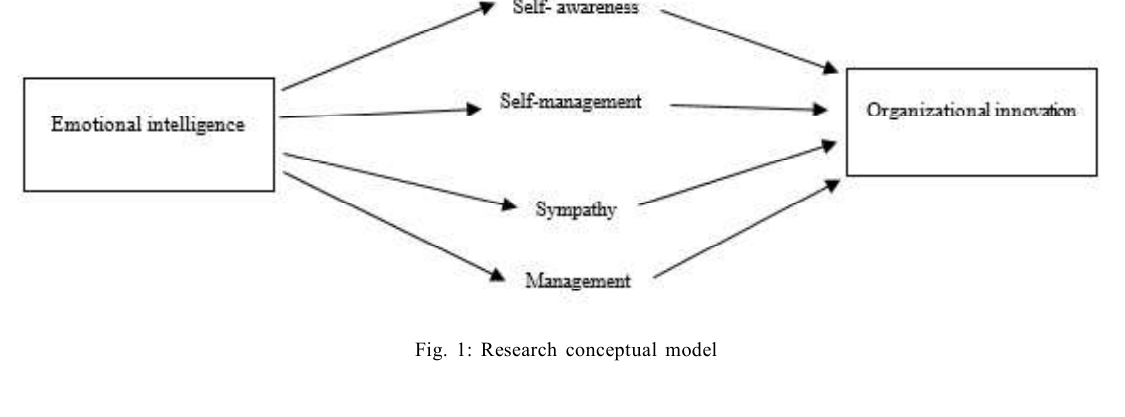
Fig. 1: Research conceptual